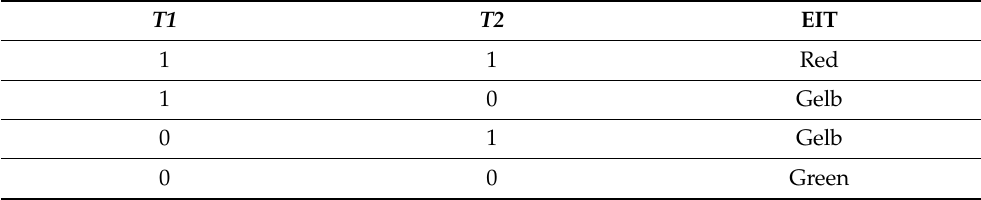
Table 10. Matrix of decision giving warnings to those interested what influnce atmospheric parame- ters have on